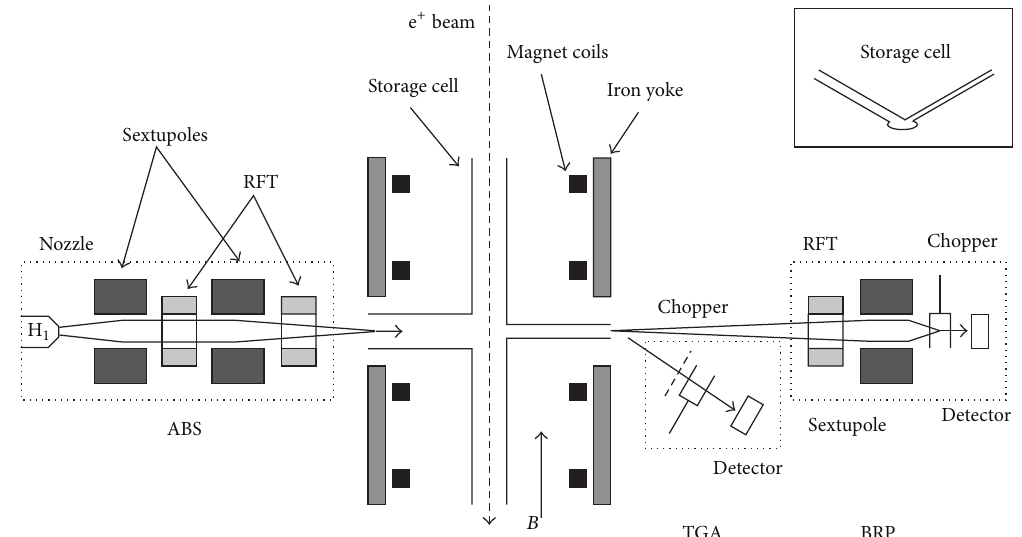
Figure 1: Schematic representation (top view) of the HERMES longitudinally polarized target (taken from [8]). From left to right: Atomic Beam Source (ABS), target chamber with cell and SC magnet coils, diagnostic system of target gas analyzer (TGA), and Breit-Rabi polarimeter (BRP).